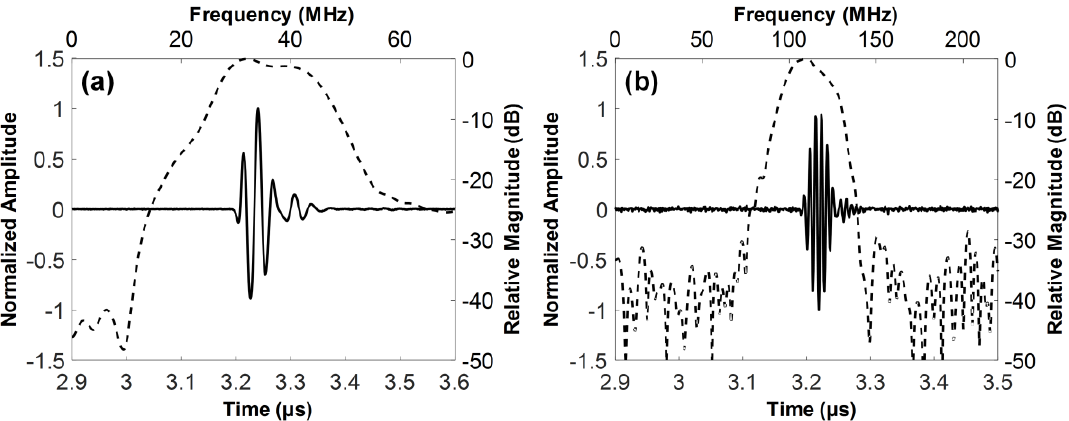
Figure 8. Measured pulse-echo responses (solid line) and their frequency spectra (dashed line): ( a ) 35-MHz and ( b ) 105-MHz elements of the dual-element focused transducer.